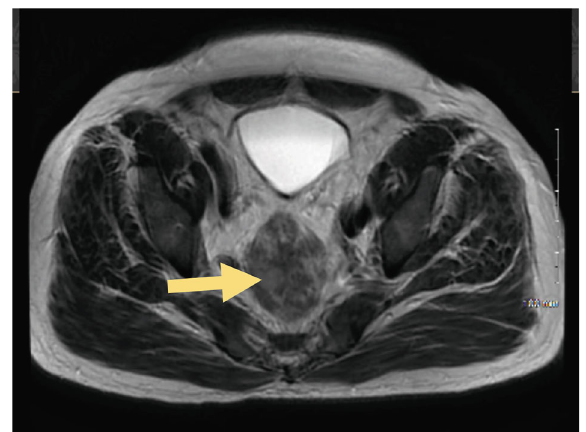
Figure 3: Axial image of MRI pelvis showing a nonspeci fi c rectal mass